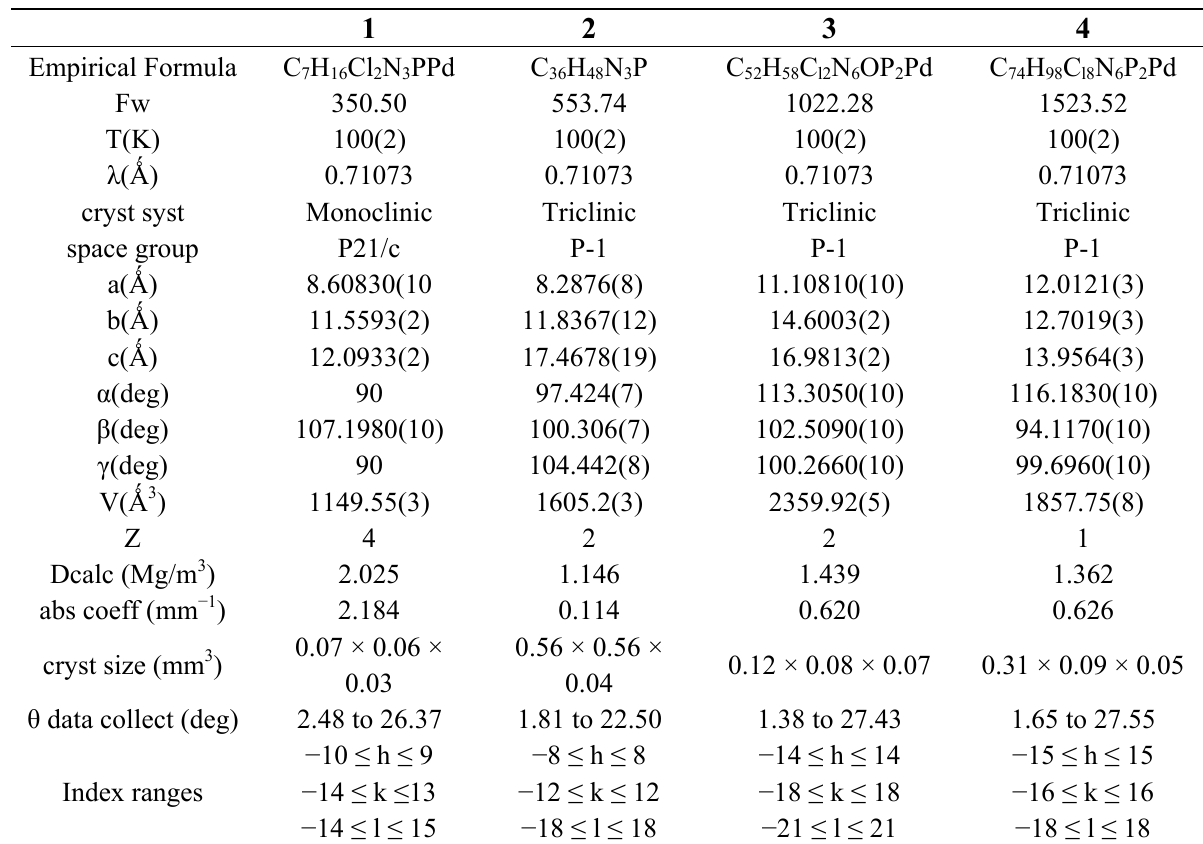
Table 4. Crystallographic data for compounds 1–4